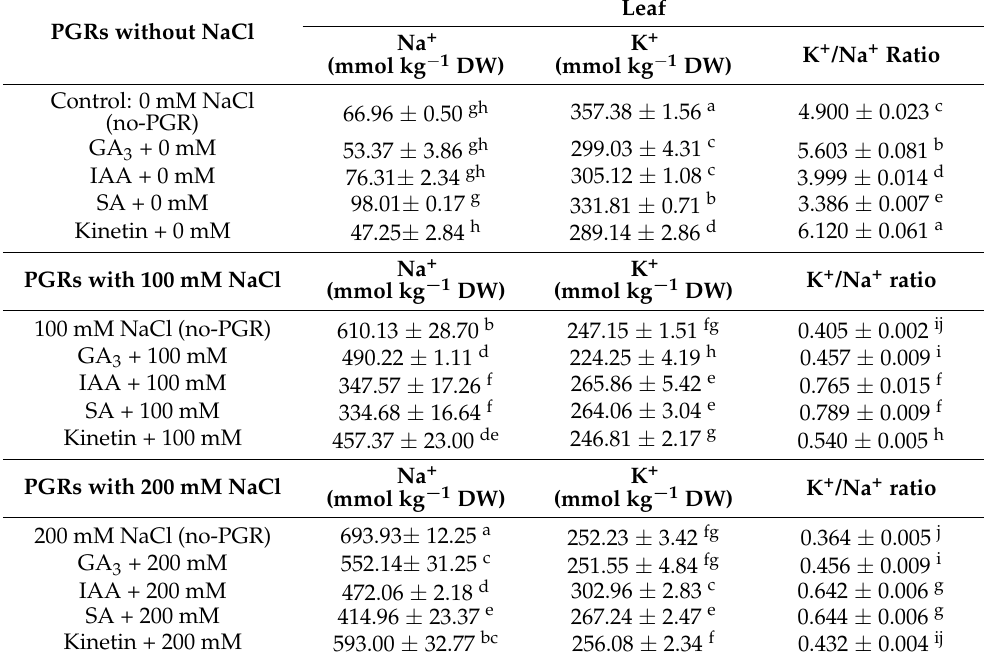
Table 2. Effect of salt stress on Na + and K + concentrations, and K + /Na + ratio in leaf of Olea europaea plants pretreated with plant growth regulators (PGRs). Data are expressed as mean ± SE